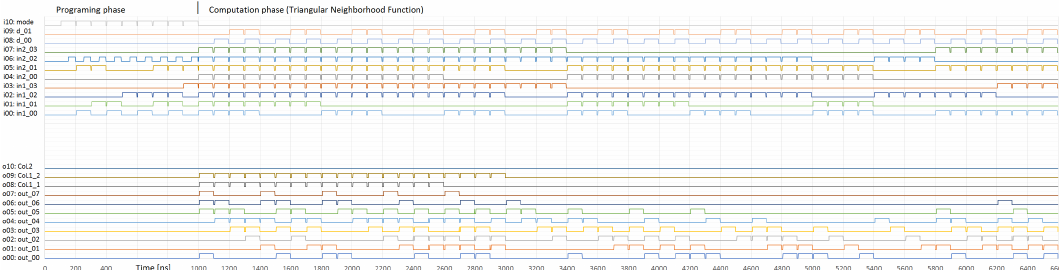
Figure 15. Input and output signals of the prototype chip—a direct binary form.